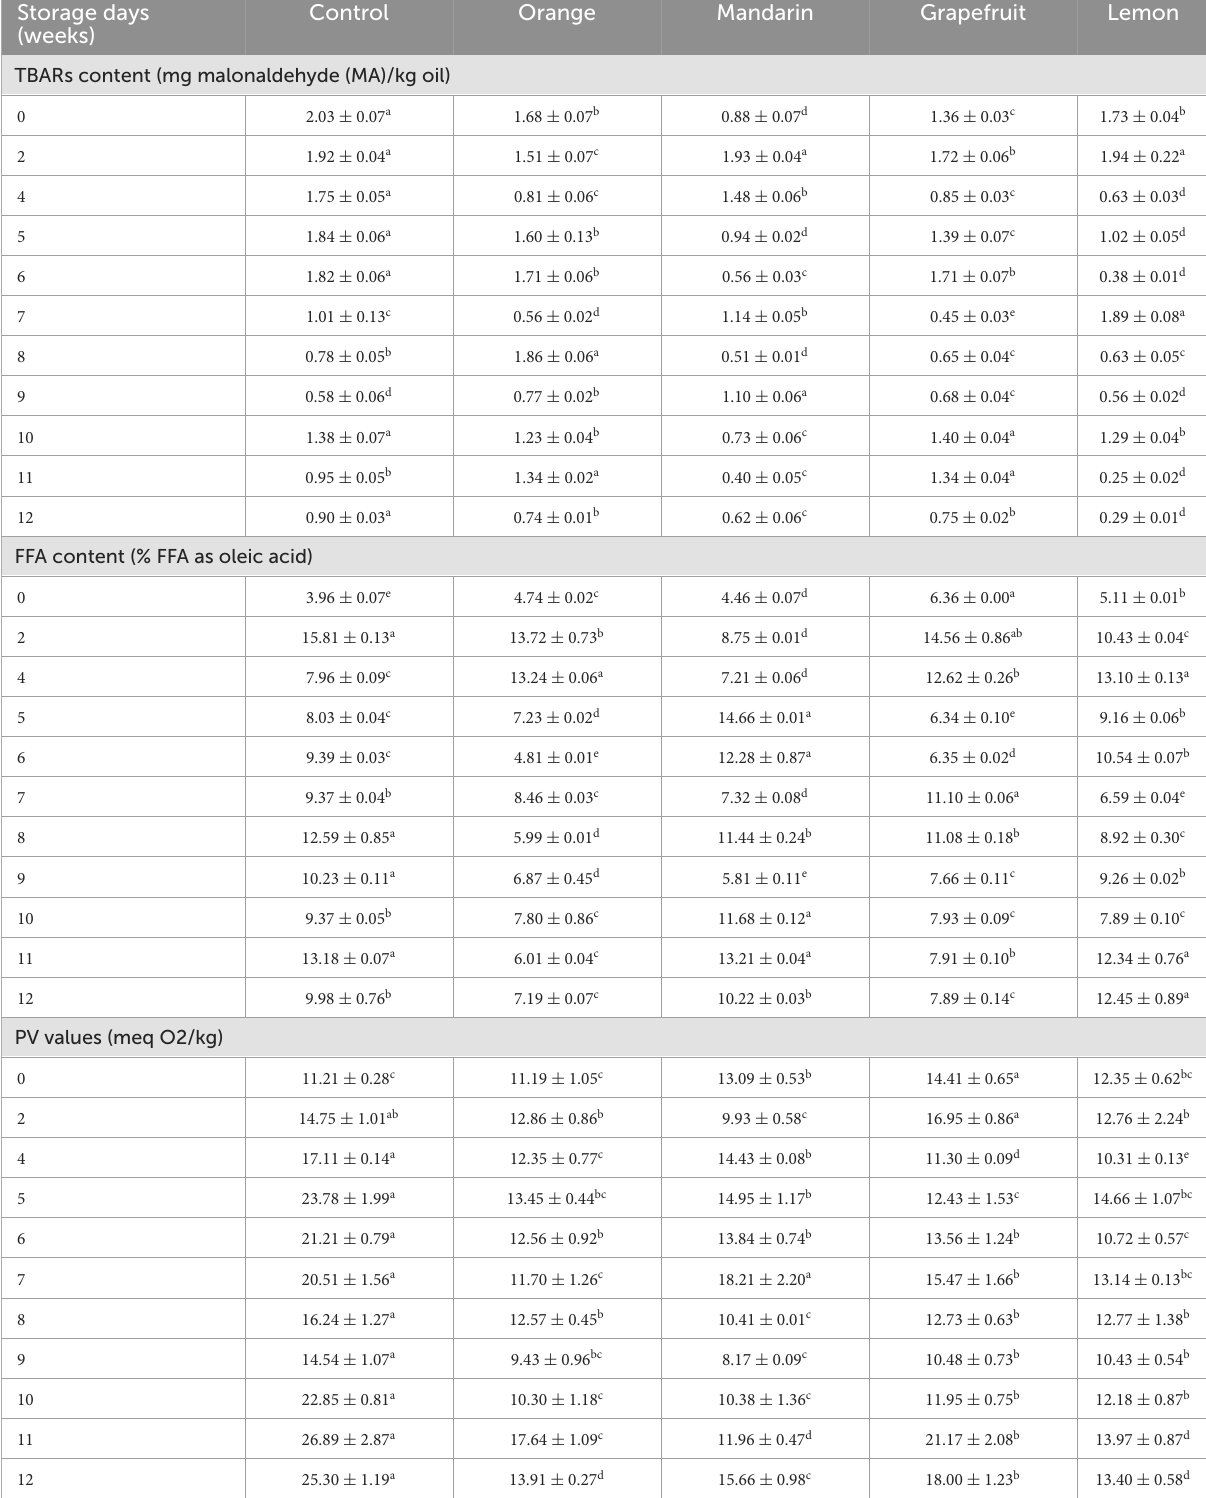
TABLE 4 The changes in PV, TBARs, and FFA contents of microencapsulated fish oil during storage. Storage days Control Orange Mandarin Grapefruit (weeks)